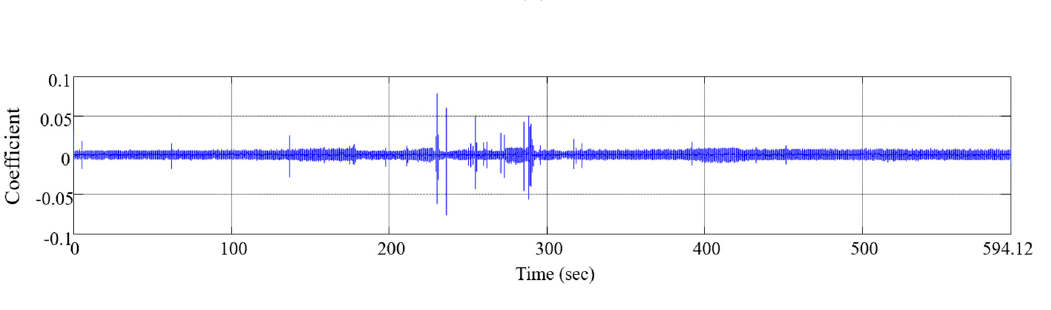
Figure 3. Continuous Wavelet Coefficient: ( a ) Scale: 5, ( b ) Scale: 10, ( c ) Scale: 15, ( d ) Scale: 20, ( e ) Scale: 25.